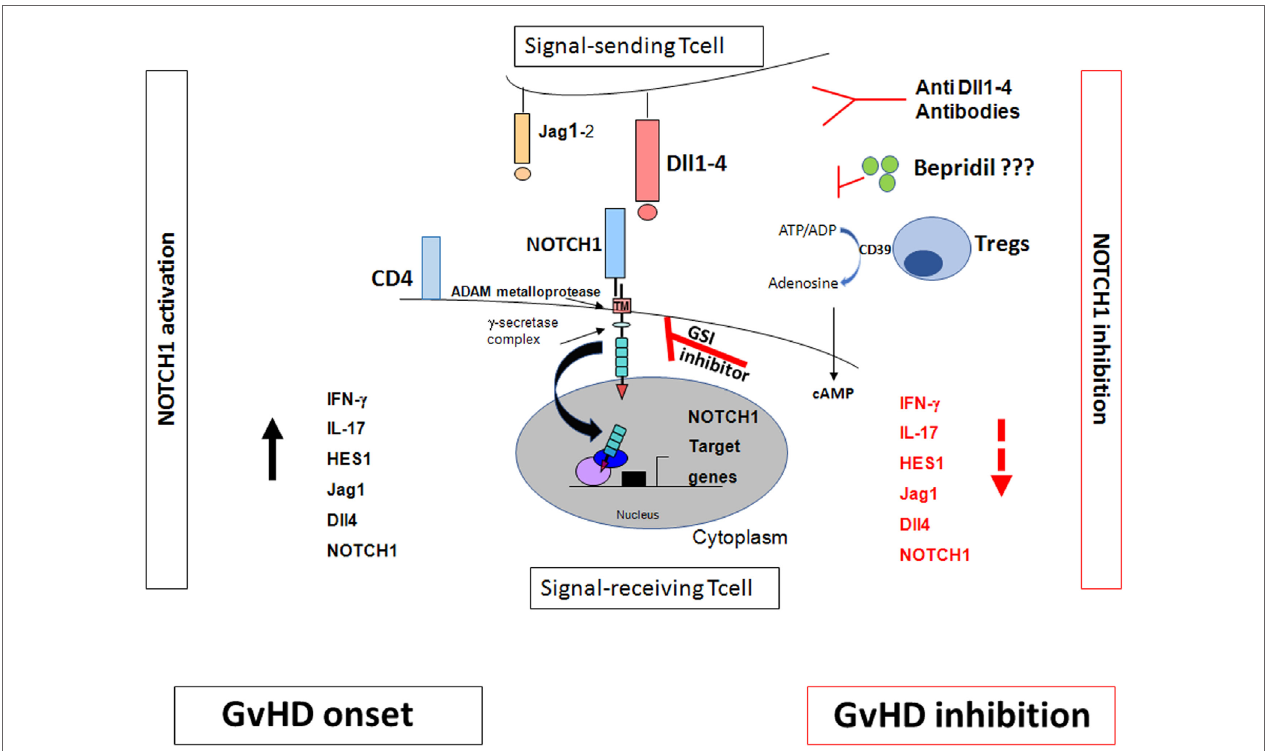
FiGURe 1 | NOTCH signaling and graft-versus-host disease (GvHD). The effects of NOTCH signaling during GvHD are dependent on NOTCH1/2 receptors in T cells and Dll1/4 ligands in the recipient, with dominant roles for NOTCH1 and Dll4. Inhibition of canonical NOTCH signaling by γ -secretase inhibitor (GSI)-inhibitor, anti Dll1–4 antibodies, bepridil, and regulatory T cells (Tregs) markedly decreased GVHD (28–30). Tregs inhibit the NOTCH/NOTCH ligand interactions. They act through the CD39/adenosine axis to inhibit the NOTCH pathway which, in turn, regulates T cell proliferation and consequently inhibits GvHD. Blocking CD39/ adenosine axis reverts NOTCH inhibition and favors GvHD onset